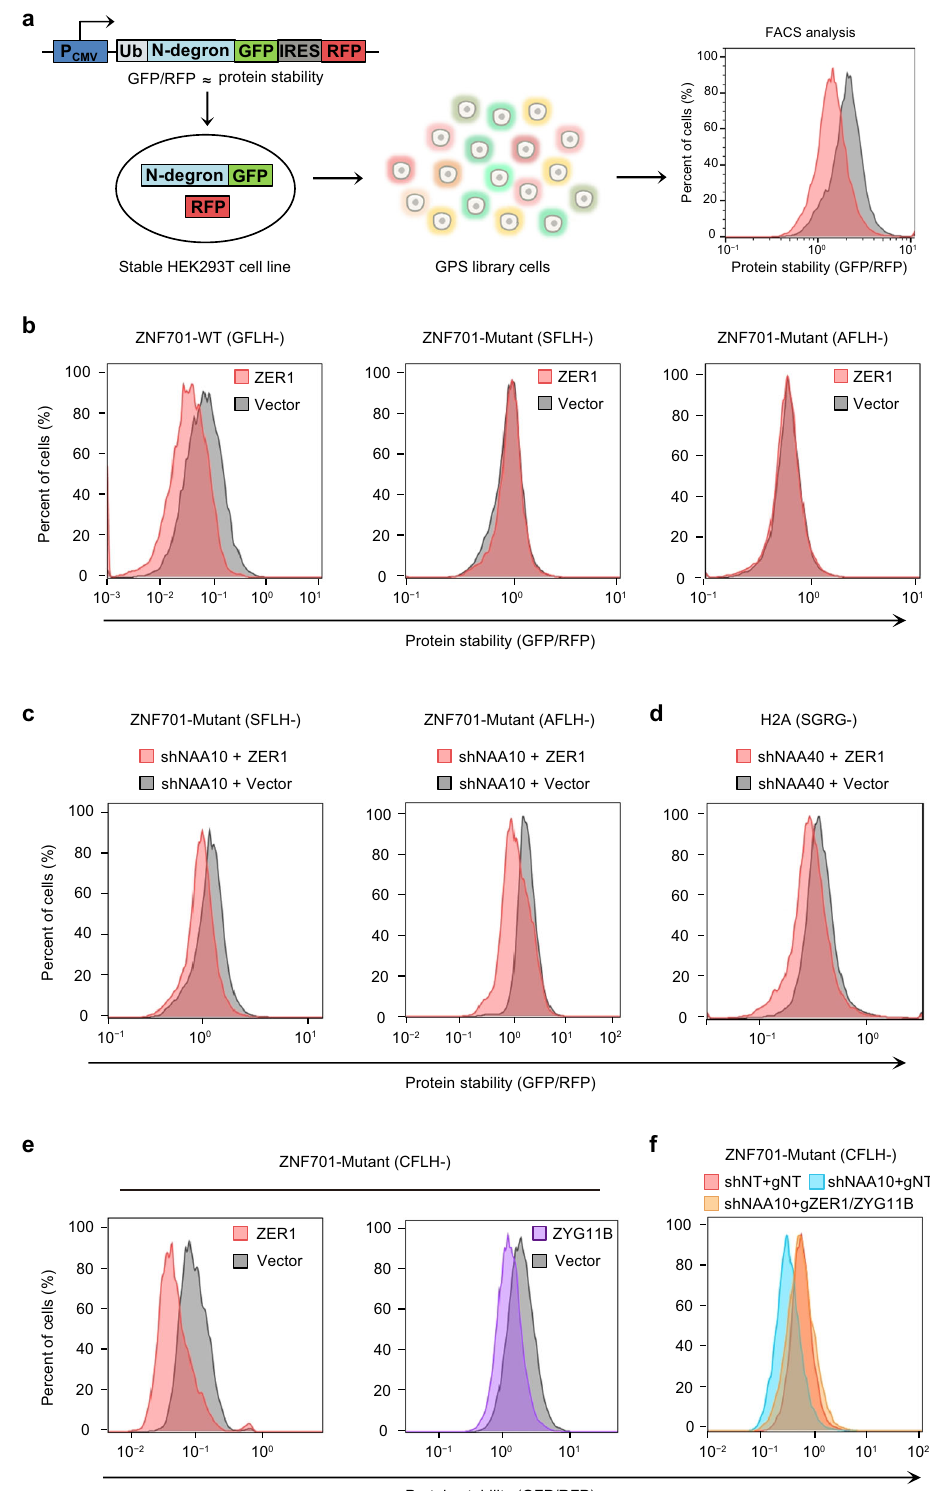
Fig. 2 | Nt-acetylation of Ser, Ala or Cys prevents them from recognition by ZER1 or ZYG11B. a Schematic of the global protein stability (GPS) assay. P CMV , cytomegalovirus promoter, Ub ubiquitin, IRES internal ribosome entry site, GFP green fl uorescentprotein,RFPred fl uorescentprotein. b StabilityanalysisofGFLH-, SFLH-orAFLH-GFPuponZER1overexpressioninHEK293TcellsbyGPS.Theratioof GFP/RFP was analyzed by fl ow cytometry. c Stability analysis of SFLH- or AFLH- fusedGFPwithfull-lengthZER1overexpressioninNAA10knockdowncelllines.The ratio of GFP/RFPwasanalyzed by fl ow cytometry. d Stability analysisof N-terminal